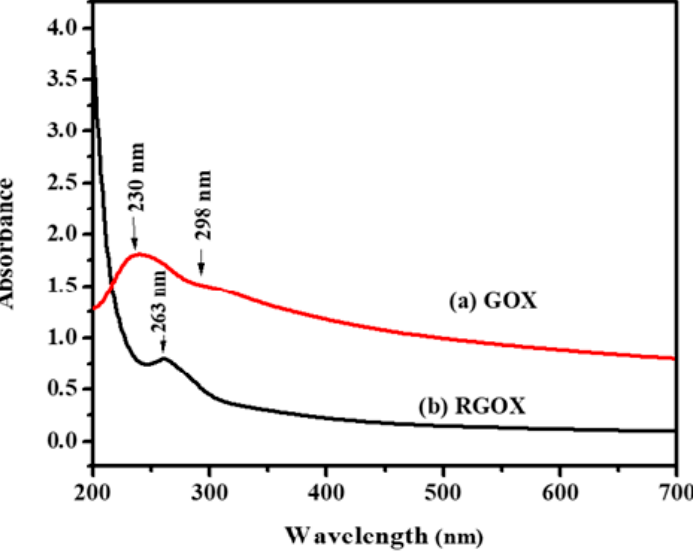
Figure 1. Ultraviolet-visible spectra analysis ( a ) GOX and ( b ) RGOX.